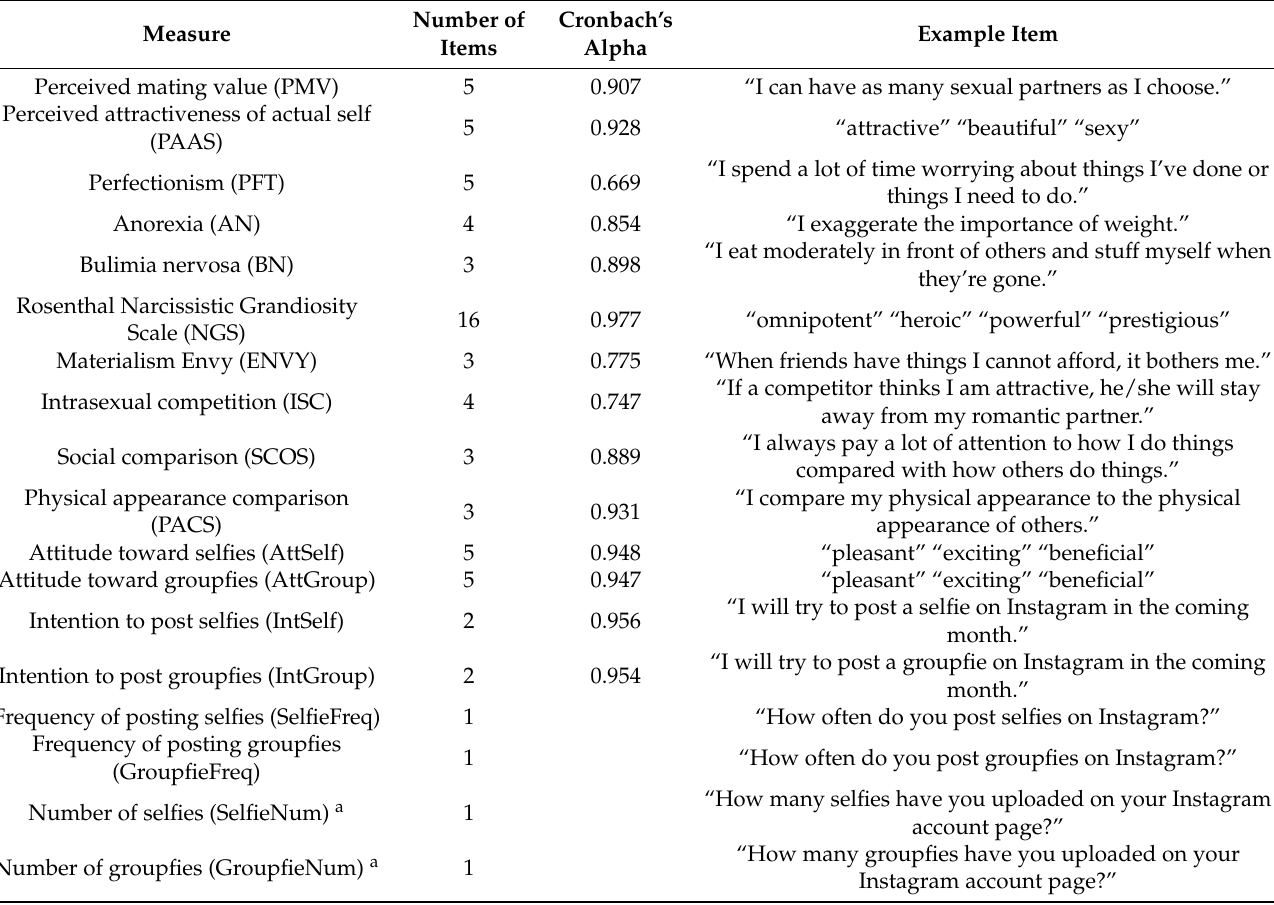
Table 5. Study 3: Number of items, Cronbach’s alpha, and an example item for each